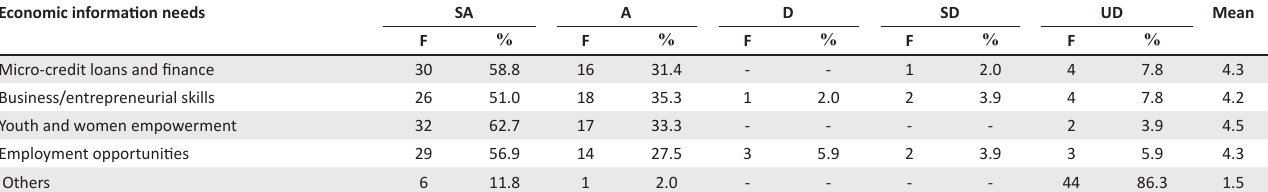
TABLE 8: Opinions of the heads of branch libraries on economic information needs of the rural dwellers ( N = 51). Economic information needs